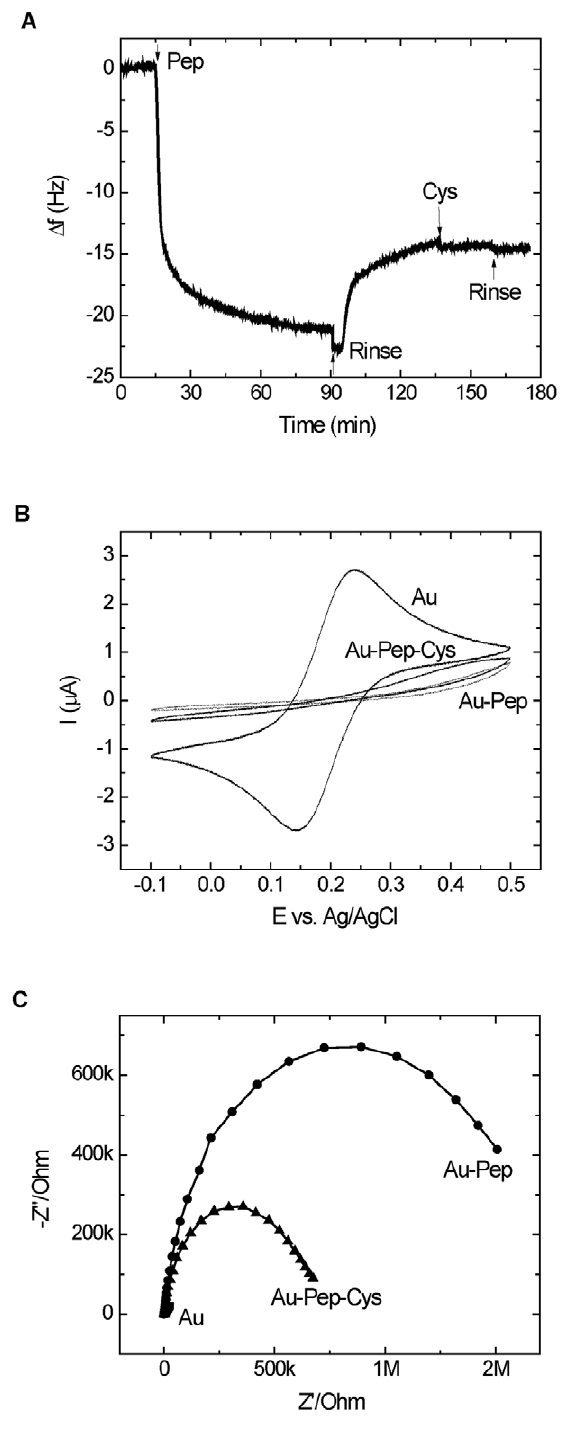
Figure 5. Sensor preparation. A) the change in frequency during the immobilization of peptide (Pep, 0.1 mM), rinsing (Rinse) and subse- quent blocking with cysteine (Cys, 1 mM) on gold using QCM; B) CV of the bare gold electrode (Au), the electrode with the peptide (Au-Pep), and the blocked electrode (Au-Pep-Cys), C) EIS of bare gold (Au), the peptide modified electrode (Au-Pep) and the blocked electrode (Au- Pep-Cys) in a 1 mM solution of Fe(CN) 64-/3- in 0.1 M NaClO 4 .